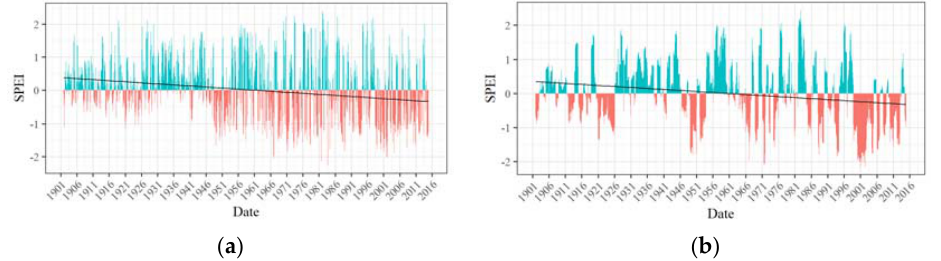
Figure 4. Homogeneous zones produced after running Spatial “K”luster Analysis using Tree Edge Removal (SKATER).